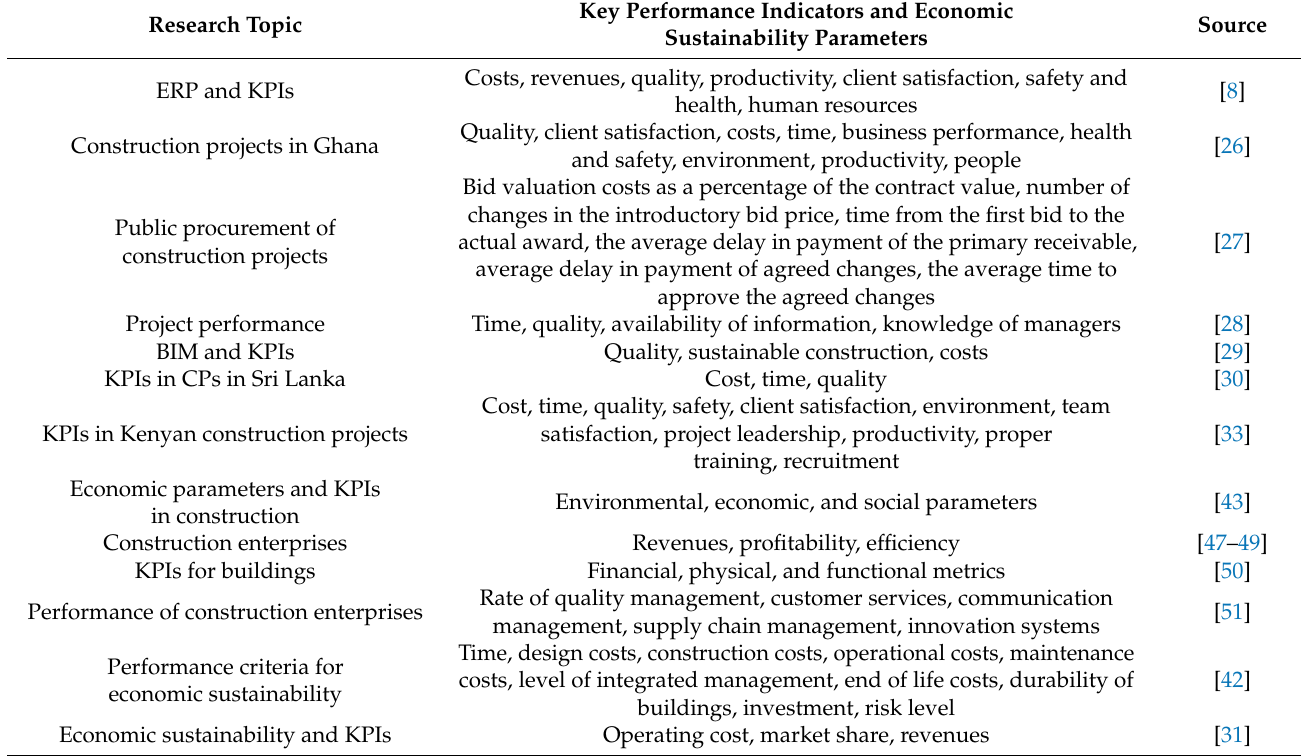
Table 1. The literature on KPIs in